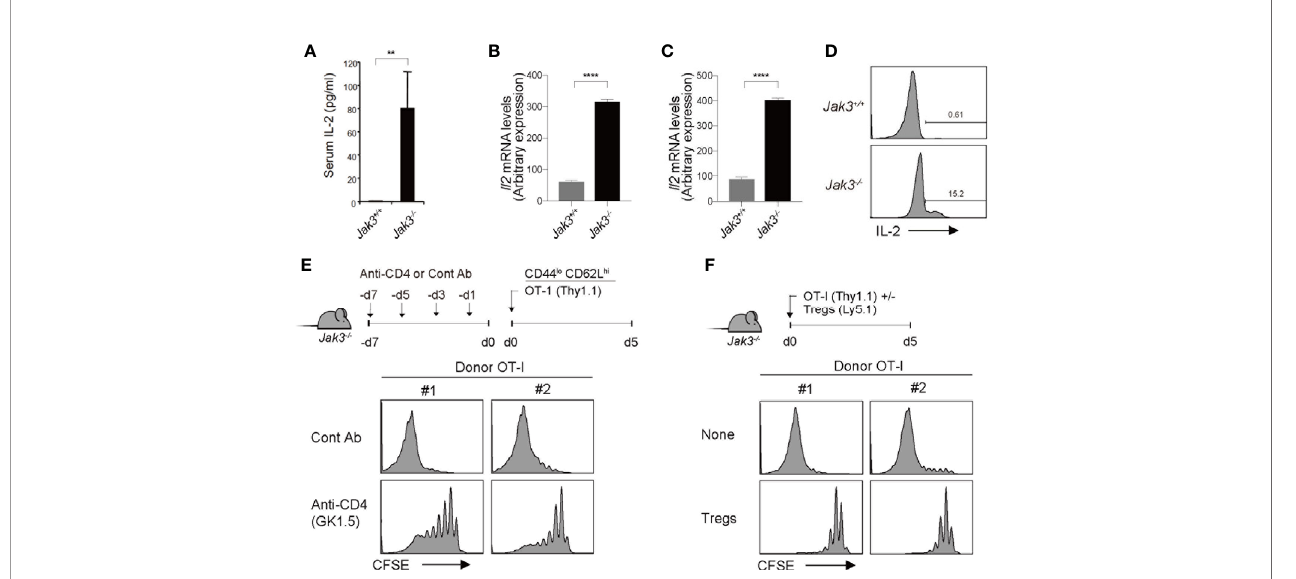
FIGURE 4 | Effect of CD4 + T cells on high levels of in vivo IL-2 in Jak3 – / – mice. (A) In vivo levels of IL-2 measured by ELISA with sera from Jak3 − / − mice and as littermate control Jak3 +/+ mice (the mean ± SD; n = 3-5 mice per group). (B, C) Spleen cells (B) and FACS-puri fi ed CD4 + T cells (C) from Jak3 − / − and Jak3 +/+ mice were analyzed for Il2 mRNA by quantitative RT-PCR. (D) Detection of in vivo IL-2 production from Jak3 − / − or Jak3 +/+ CD4 + T cells by using direct intracellular cytokine staining. (E) Jak3 − / − mice were injected i.p. with either anti-CD4 mAb (GK1.5) or as a control isotype IgG (total 4 injections every 2 days; 100 m g per mouse; n = 2 – 4 mice). The mice were injected i.v. with FACS-puri fi ed CFSE-labeled naive OT-I CD8 + T cells (Thy1.1; 1 × 10 6 cells per mouse; n = 2-4 mice). At day 5 after adoptive transfer, spleen cells of the recipient mice were analyzed for CFSE dilution by fl ow cytometry. (F) FACS-puri fi ed CFSE-labeled naive OT-I CD8 + T cells (Thy1.1; 1 × 10 6 cells per mouse) were injected i.v. with or without CD4 + Tregs (~0.2 × 10 6 cells per mouse) puri fi ed from Foxp3-GFP mice into Jak3 − / − mice ( n = 2 – 4 mice). Spleen cells of the recipient mice were analyzed on day 5 for CFSE dilution by fl ow cytometry. ** P<0.01 , ****